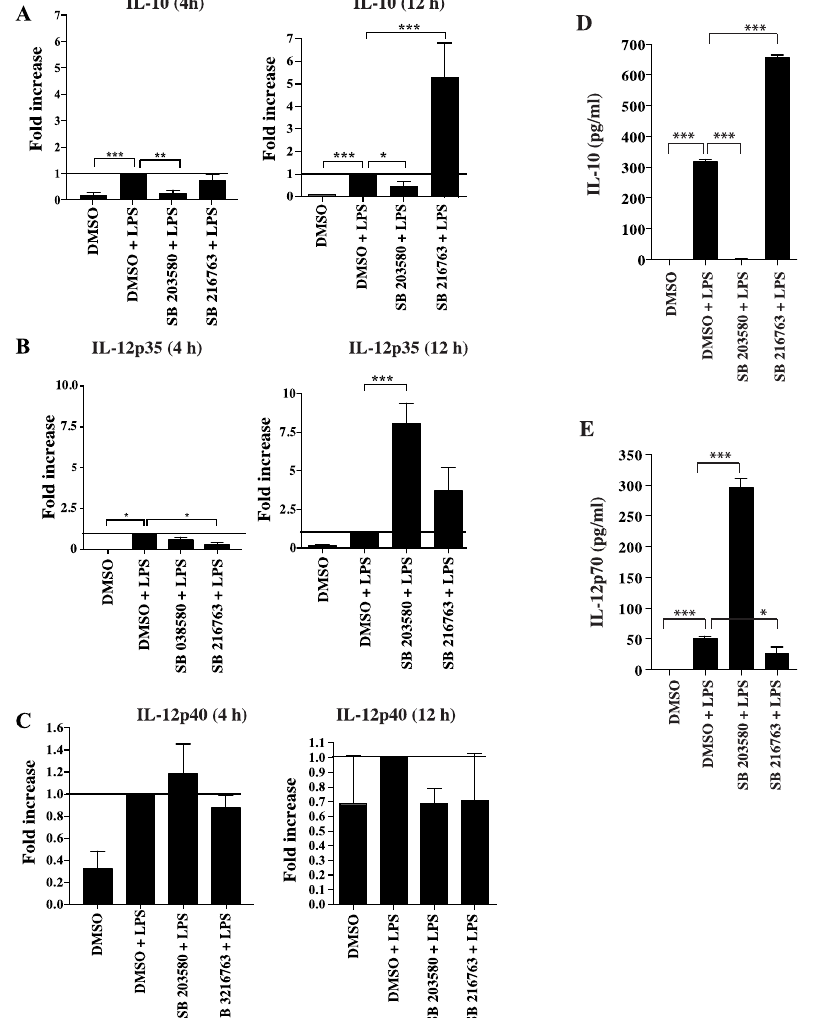
Figure 3. Role of p38 MAPK/CREB and GSK3 β /CREB axis in regulating IL-10 and IL-12 in GM/DCs. Bone marrow-derived GM/DCs were preincubated for 1 h in the presence of a p38 MAPK (SB203580,